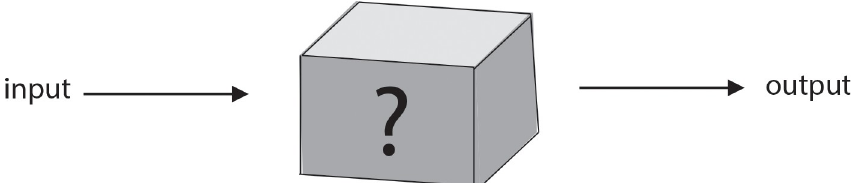
Fig 2. Understand what Artificial Intelligence is. The predictive behaviors of AI models can sometimes be hidden from programmers, who must then view the internal workings as a “black box,” analyzing them based on their inputs and